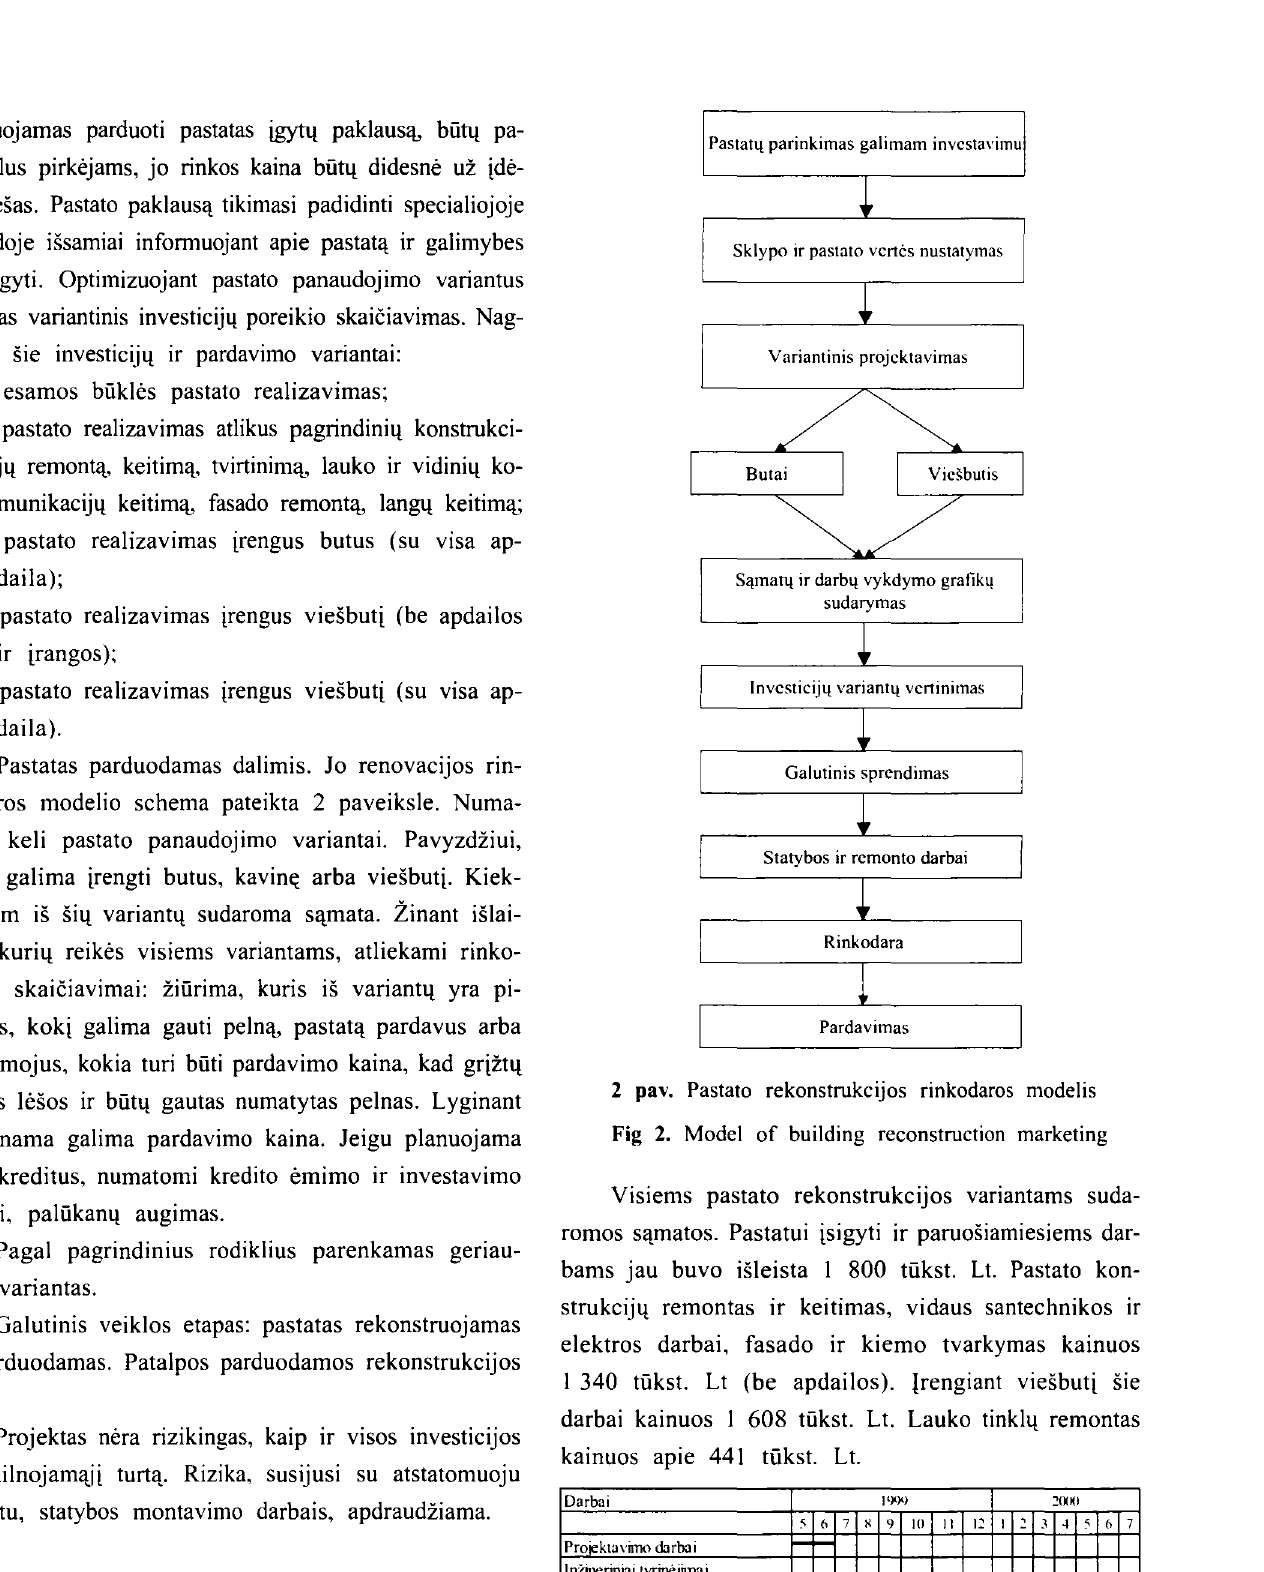
Fig 3. Schedule of reconstruction work with interior